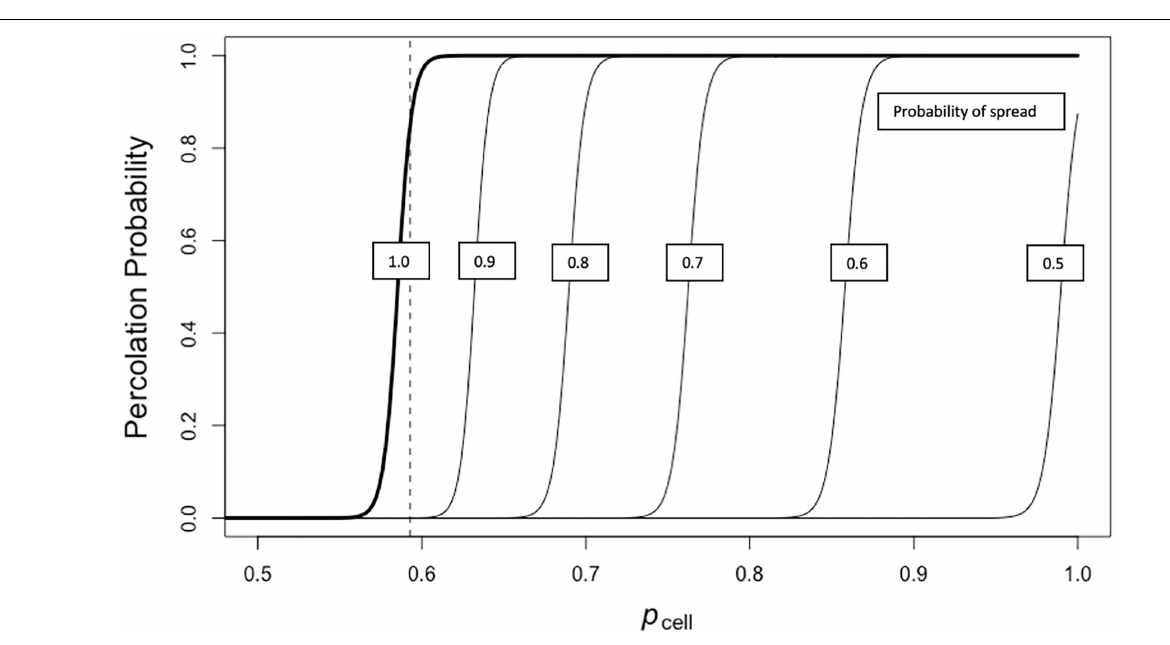
FIGURE 6 | Percolation probability of fire across a landscape with different probabilities of spread ( s ij ) given varying levels of p cell (Experiment